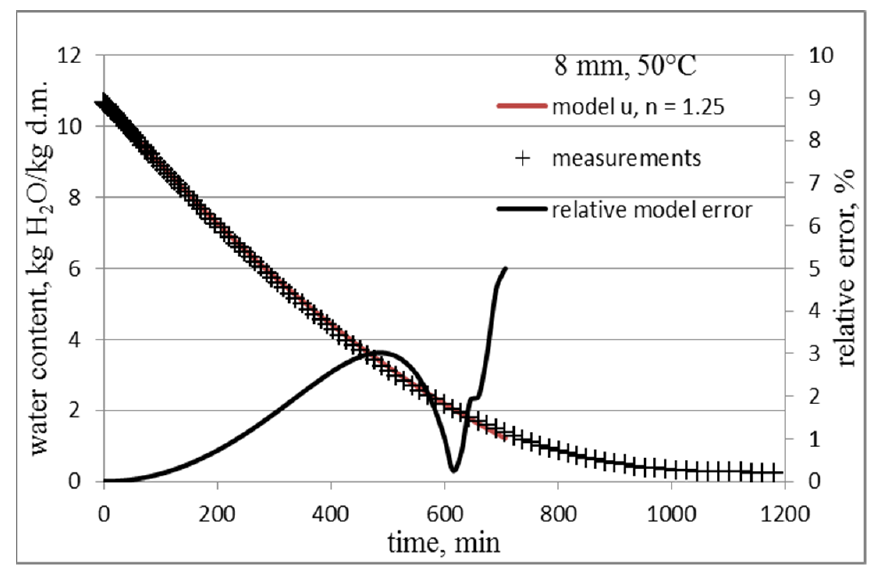
Figure 2. Model of water content changes in leek slices 8 mm thick, during drying at temperature 50 °C, when n = 1.25.